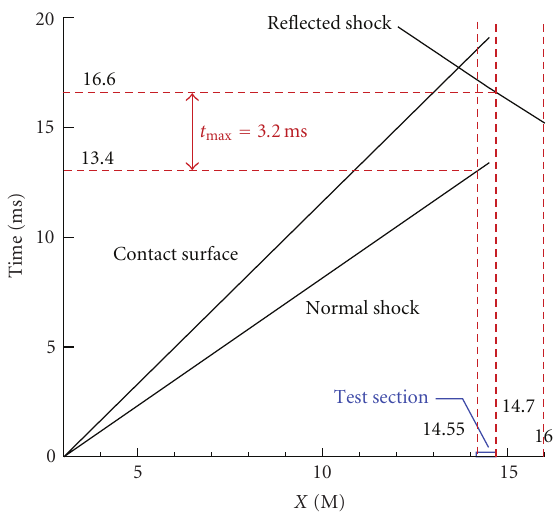
Figure 3: 1D theorem determined result.